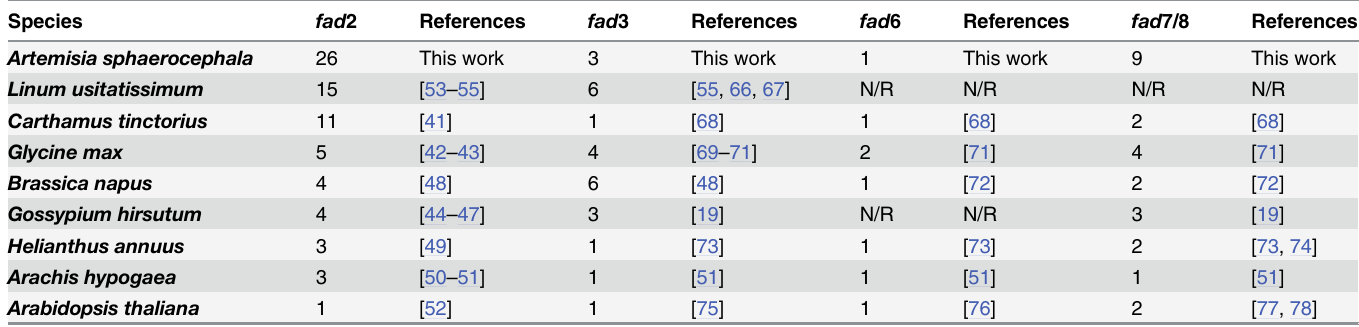
Table 6. Numbers of fad genes in different species.